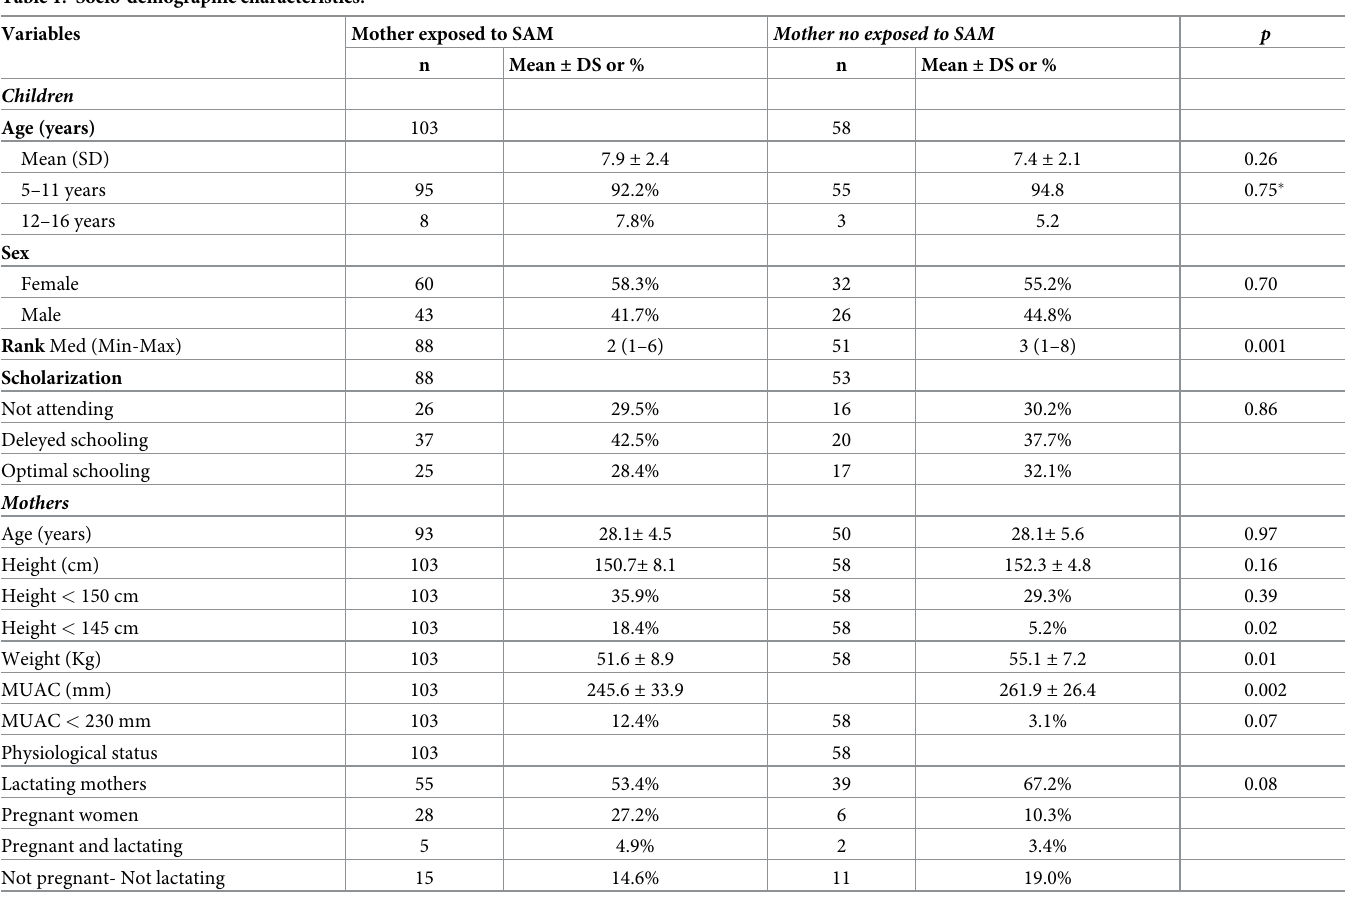
Table 1. Socio-demographic